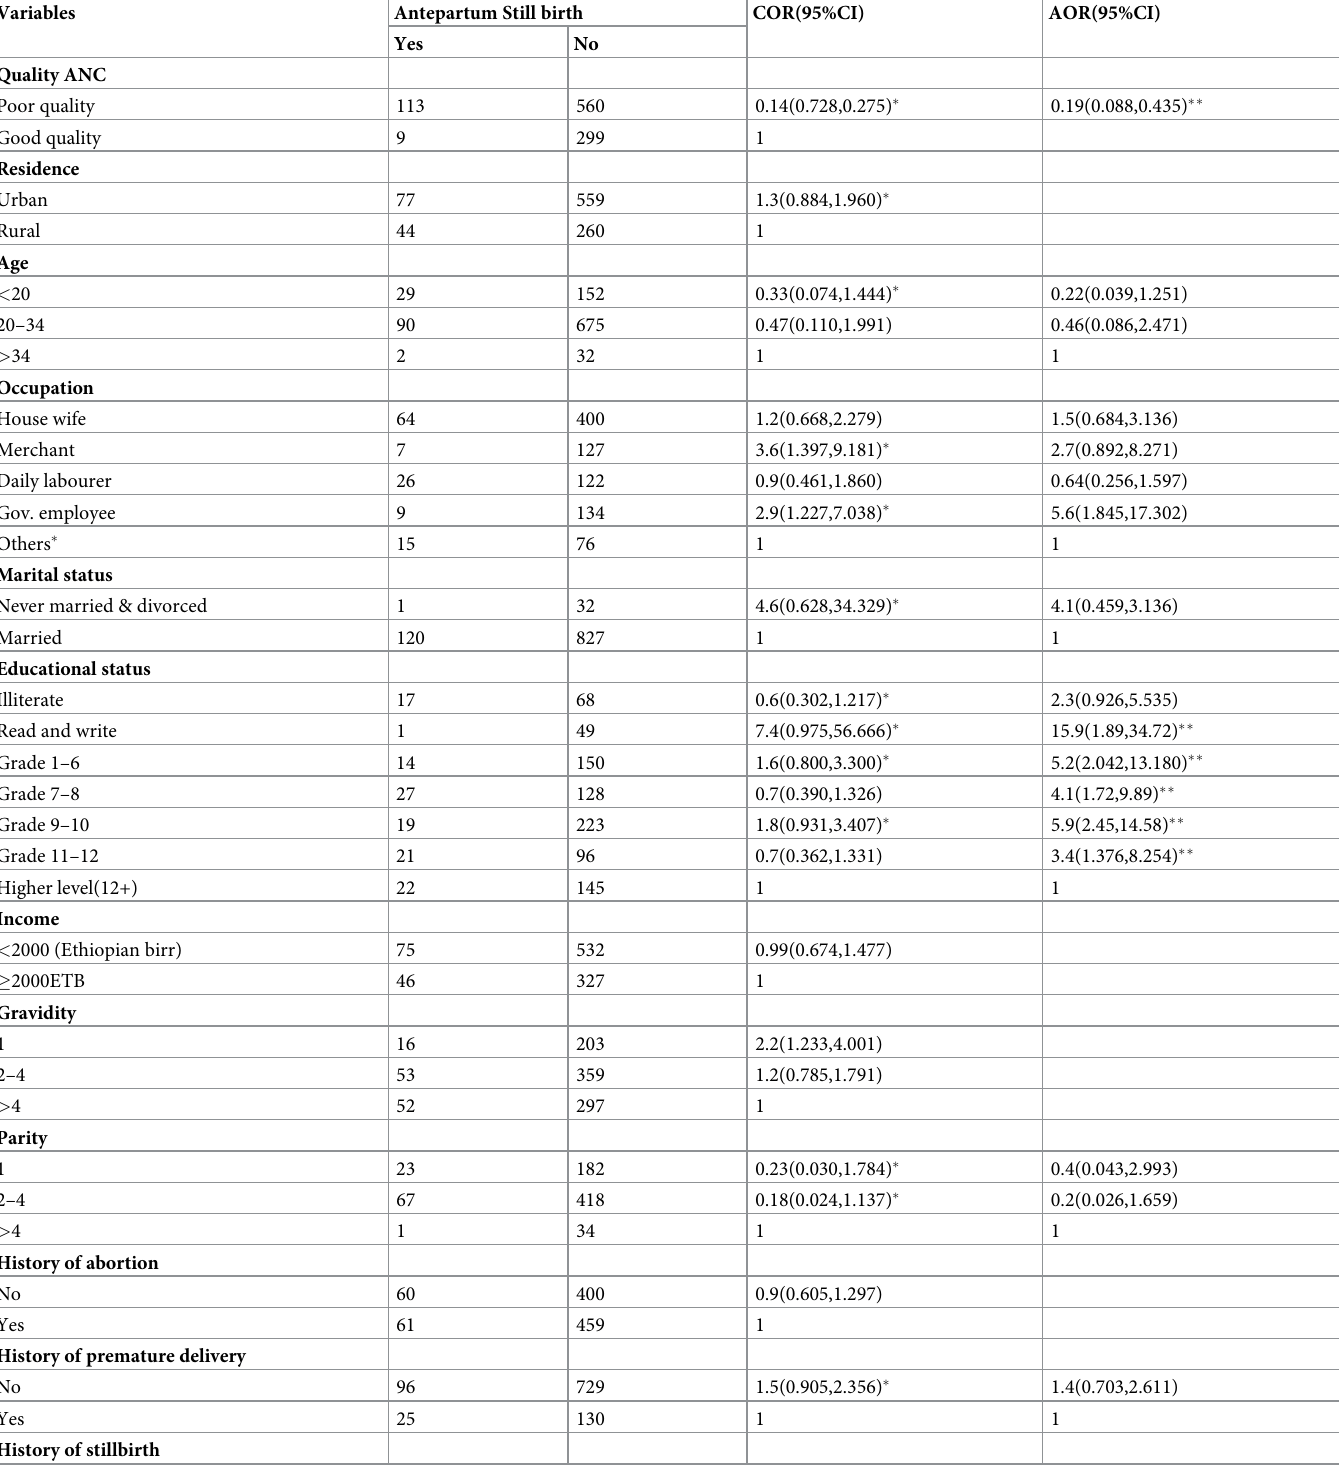
Table 2. Generalised estimating equation logistic regression to identify determinants of antepartum stillbirth among pregnant women attending ANC at public health facilities of Hossana Town (n = 980), July 2017 to June